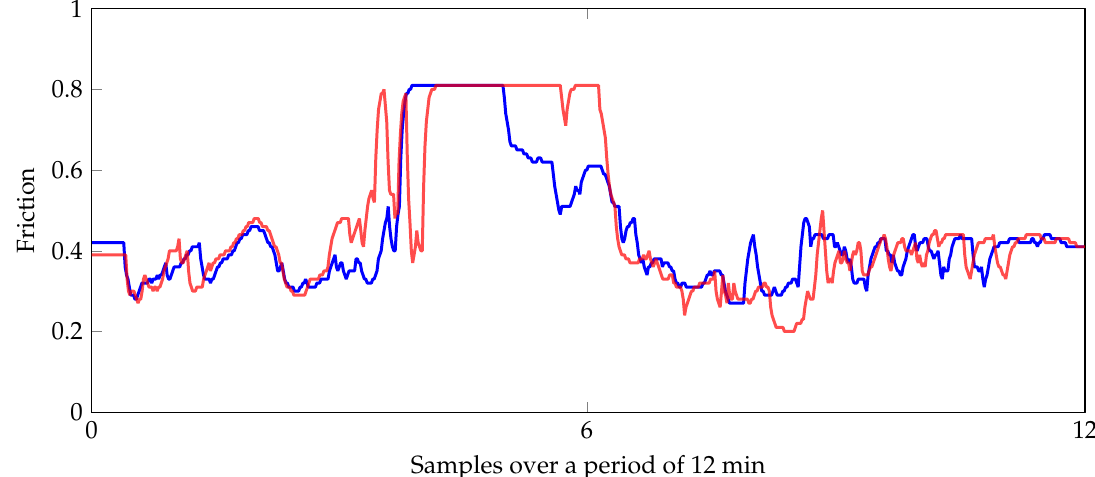
Figure 3. RCM411 friction plots from two runs along the same test route: blue, run 1; red, run 2.